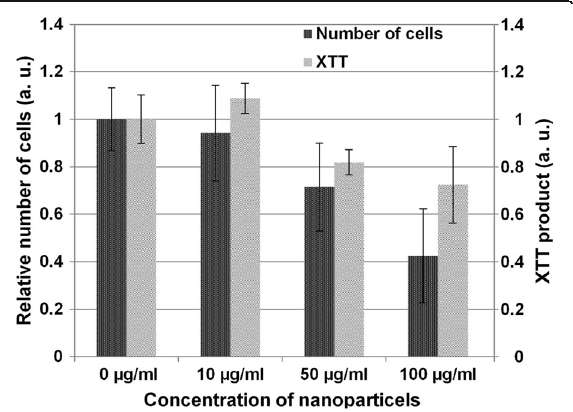
Fig. 2 Impact of nanoparticles on cell viability. Concentration- dependent XTT reduction measured after 1 day of cells being incubated with different concentrations of nanoparticles. The number of cells counted at the end of the XTT assay is expressed relative to untreated cells. Values are expressed as means ± standard deviation of two independent experiments with six